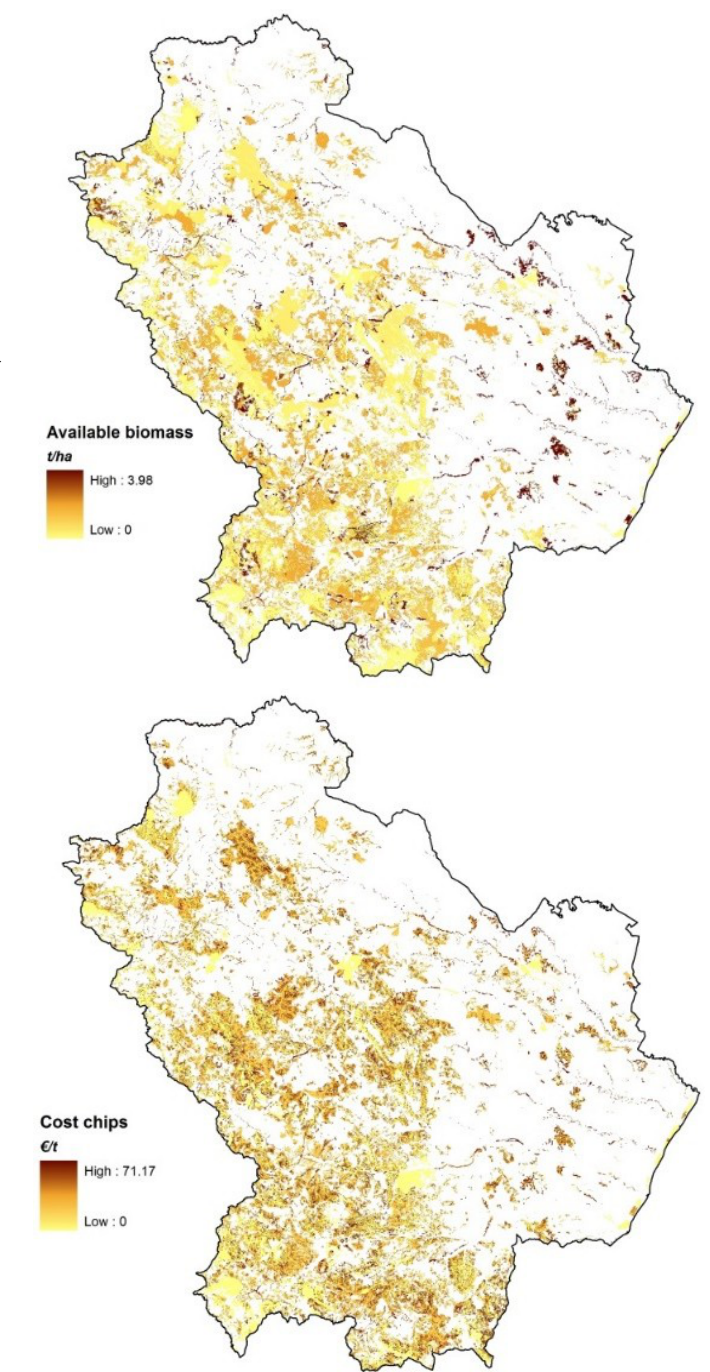
Figure 3. Available biomass ( a ) and utilization costs ( b